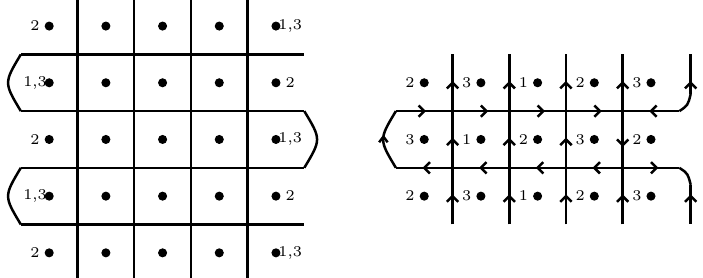
Figure 27 . Left panel: anti-Correlated alt boundary conditions correspond to re(cid:13)ecting boundary conditions in the six vertex model, but where the pairing of arrows on the left and right boundary are anti-correlated. Right panel: the Hamiltonian/Transfer Matrix that describes the vertex model acts on a chain with an extra spin that is decoupled from the rest of the system. This extra spin has the e(cid:11)ect of adding (cid:6) to the total